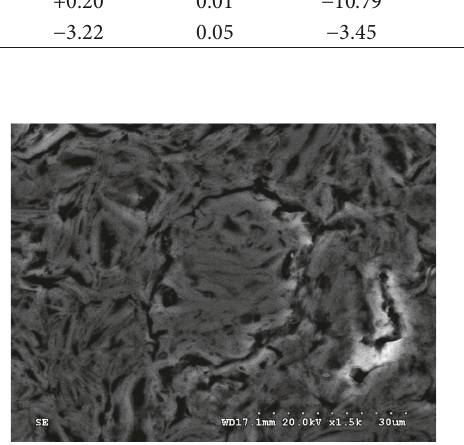
Figure 6: SEM image of A3-3 MG oxidized at 550 ∘ C to 10% weight loss at 1500x Mag.